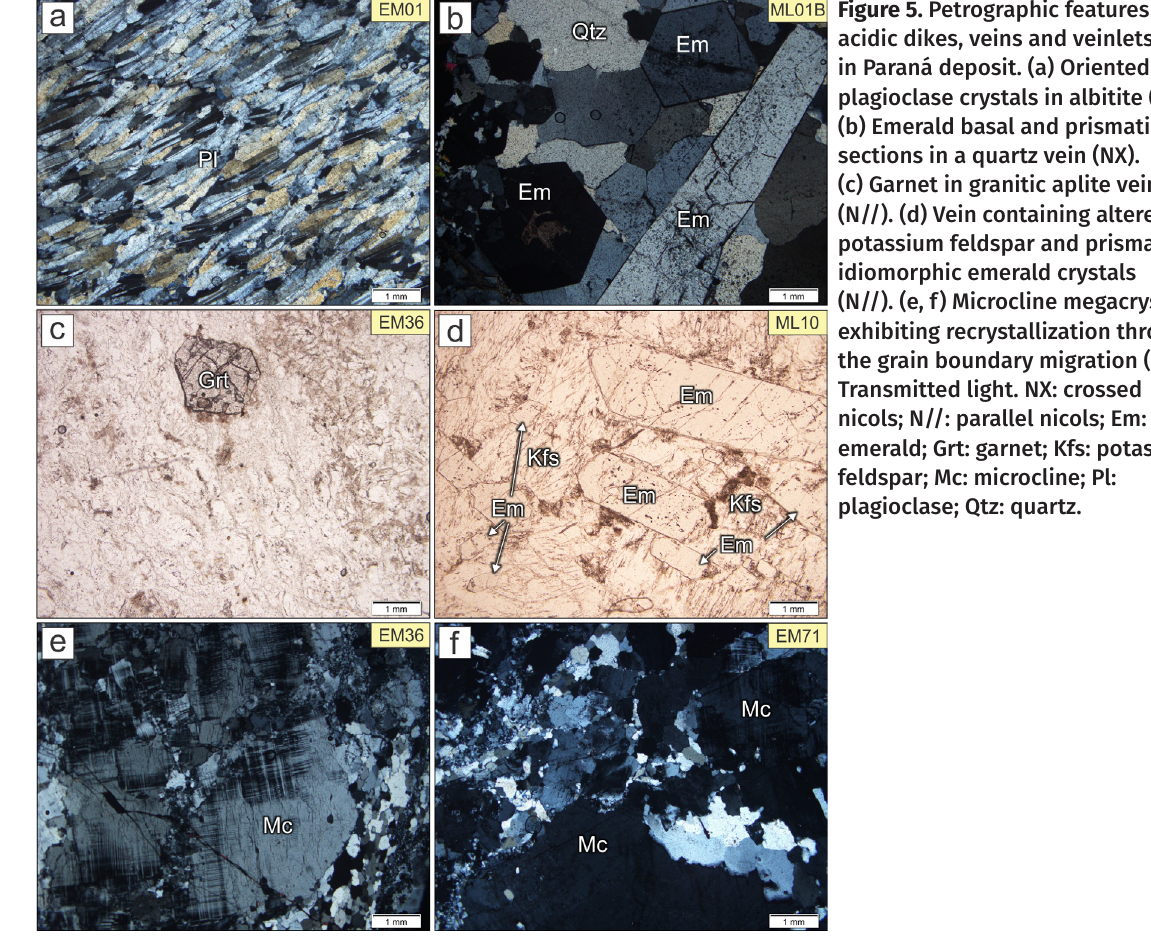
contents are between 45.67 and The SiO 2 52.36 wt.%, showing the basic nature of the host O (11.03-14.58 wt.%), schist. They present high Al 2 3 O (7.51- as well as MgO (12.90-14.55 wt.%) and Fe 2 3 O (5.52-9.64 wt.%), CaO 10.84 wt.%), followed by K 2 O (0.49-2.00 wt.%). The (0.89-4.50 wt.%) and Na 2 O concentrations ranging samples also show P 2 5 from 0.55 to 1.11 wt.%. Chromium contents are constantly low, ranging from 0.111 to 0.141 wt.%. Figure 5. Petrographic features of acidic dikes, veins and veinlets in Paraná deposit. (a) Oriented plagioclase crystals in albitite (NX). (b) Emerald basal and prismatic sections in a quartz vein (NX). (c) Garnet in granitic aplite vein (N//). (d) Vein containing altered potassium feldspar and prismatic idiomorphic emerald crystals (N//). (e, f) Microcline megacrystals exhibiting recrystallization through the grain boundary migration (NX). Transmitted light. NX: crossed nicols; N//: parallel nicols; Em: emerald; Grt: garnet; Kfs: potassium feldspar; Mc: microcline; Pl: plagioclase; Qtz: